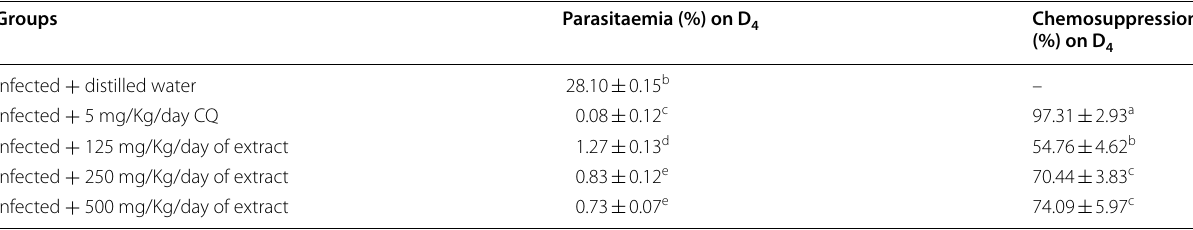
Values are mean S.E.M ( n 8) ± = CQ chloroquine Values with different alphabet superscripts in the same column are significantly different ( P < 0.05)